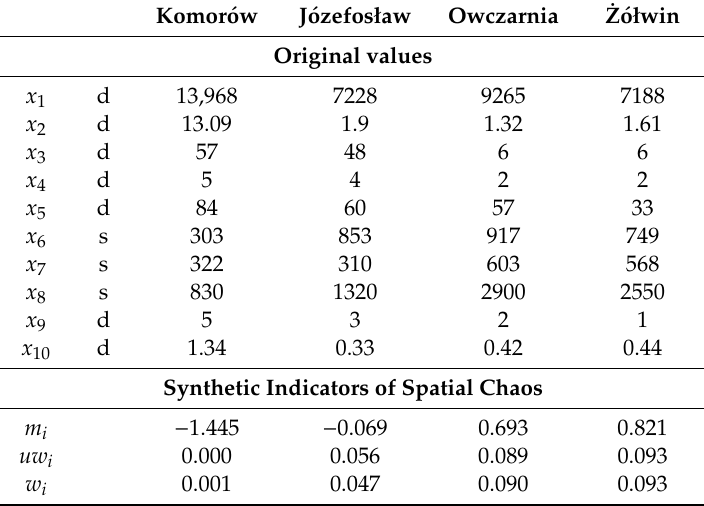
Table 3. Results obtained for individual